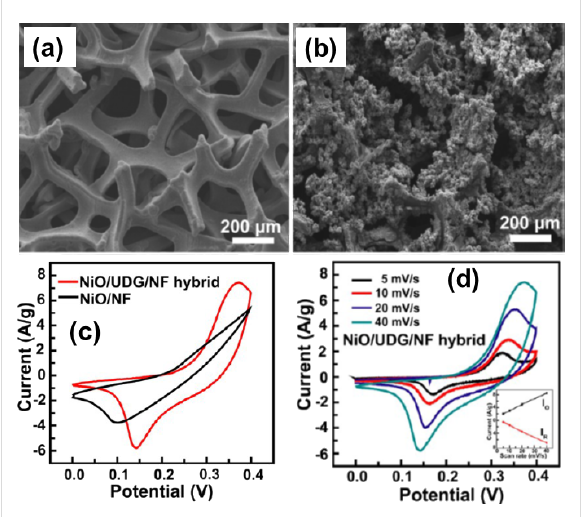
Figure 7: SEM images of (a) 3D ultrathin derived graphene/Ni foam (UDG/NF) scaffold and (b) NiO/UDG/NF hybrid after chemical bath deposition (CBD) growth of NiO nanoflakes. (c) Comparison of cyclic voltammograms of the NiO/UDG/NF hybrid and NiO/NF electrode at a scan rate of 40 mV/s. (d) CV curves of the NiO/UDG/NF hybrid at dif- ferent scan rates and linear response of the peak current intensity with the scan rate. Reprinted (adapted) with permission from [203], copy- right 2014 American Chemical Society.